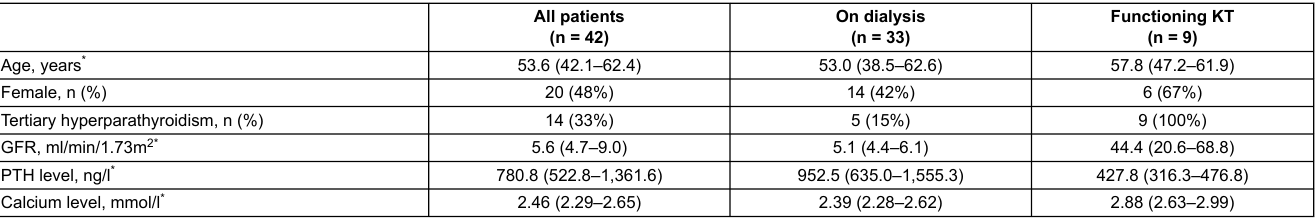
Table 1: Patient characteristics.